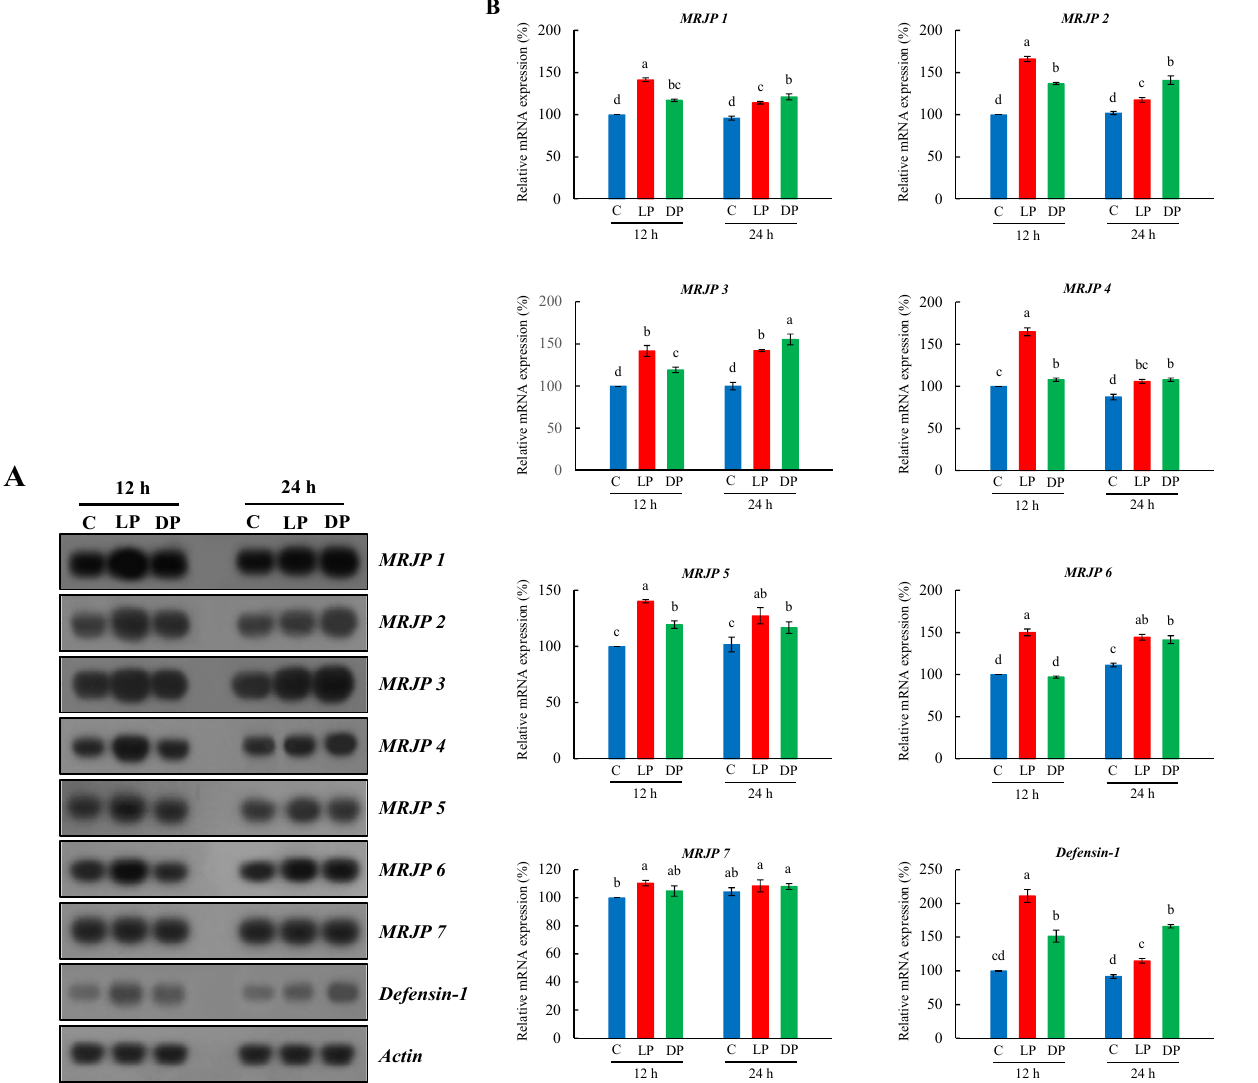
Figure 2. Expression profile of MRJPs 1–7 and defensin-1 in hypopharyngeal glands of A. mellifera nurse bees fed with live or heat-killed P. larvae . ( A ) The expression of MRJPs 1–7 and defensin-1 , as ascertained by northern blot analysis ( n = 7). β -Actin was used as an internal control to depict the total RNA loading amount. C, untreated controls; LP, feeding with live P. larvae ; DP, feeding with heat-killed P. larvae . 12 h and 24 h represent feeding time. ( B ) The relative levels of MRJPs 1–7 and defensin-1 mRNAs represent the average band densities of the target genes normalized to the expression levels of the controls (12 h). The bars represent the mean ± SD from three measurements. A one-way ANOVA test was used to determine the significant difference ( p < 0.05) with different lowercase letters (a–d).